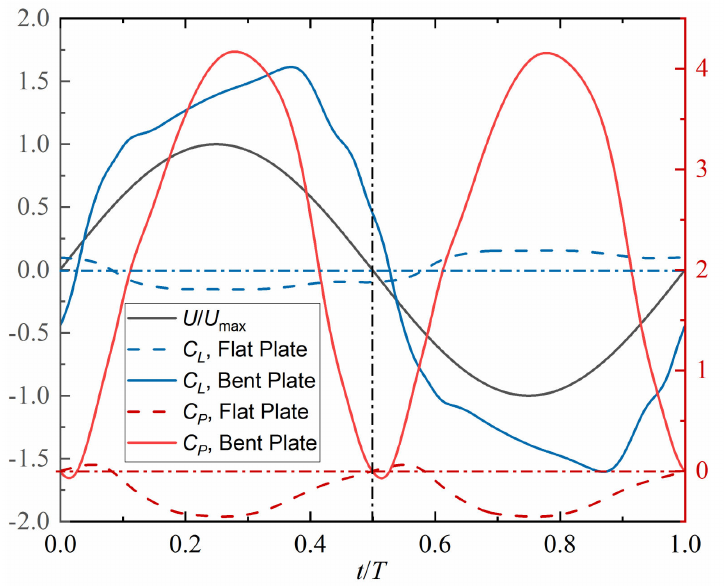
Figure 8. Variations of lift coefficient, power coefficient, and plunging velocity in one cycle for flat and bent